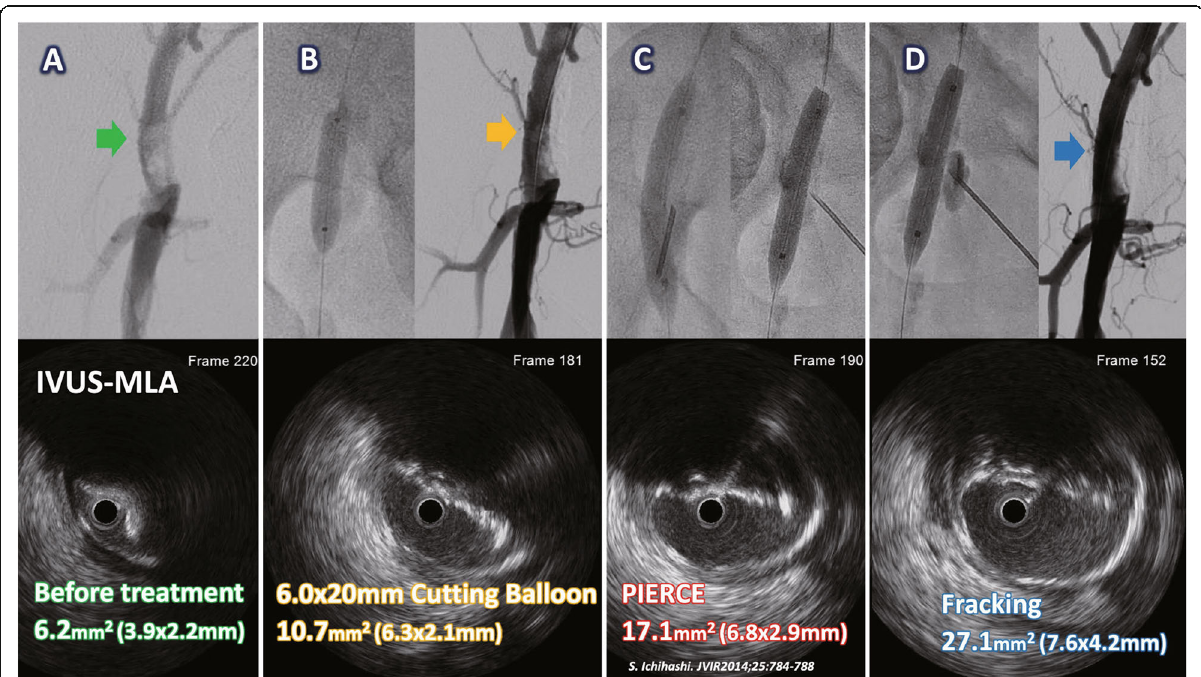
Fig. 1 Angiography and intravascular ultrasound (IVUS) of the treatment with the fracking technique in case 1. A Control angiography for quantitative vessel analysis (QVA) showed stenosis of 94% in eccentric calcified plaque in the right common femoral artery (green arrow), and IVUS before treatment showed a minimal lumen area (MLA) of 6.2-mm 2 . B After dilatation with a 6.0 × 20-mm cutting balloon, QVA showed 24% stenosis (yellow arrow), and the MLA was 10.7-mm 2 . C After a 7.0 × 40-mm noncompliant balloon inflation and percutaneous direct needle puncture of calcified plaque (PIERCE) to modify the calcification (Ichihashi et al. 2014), the MLA was 17.1-mm 2 . D After the fracking was repeated at three locations at up to 8-atm, QVA showed an improvement of stenosis to 16% (blue arrow), and the MLA was significantly much greater, to 27.1-mm